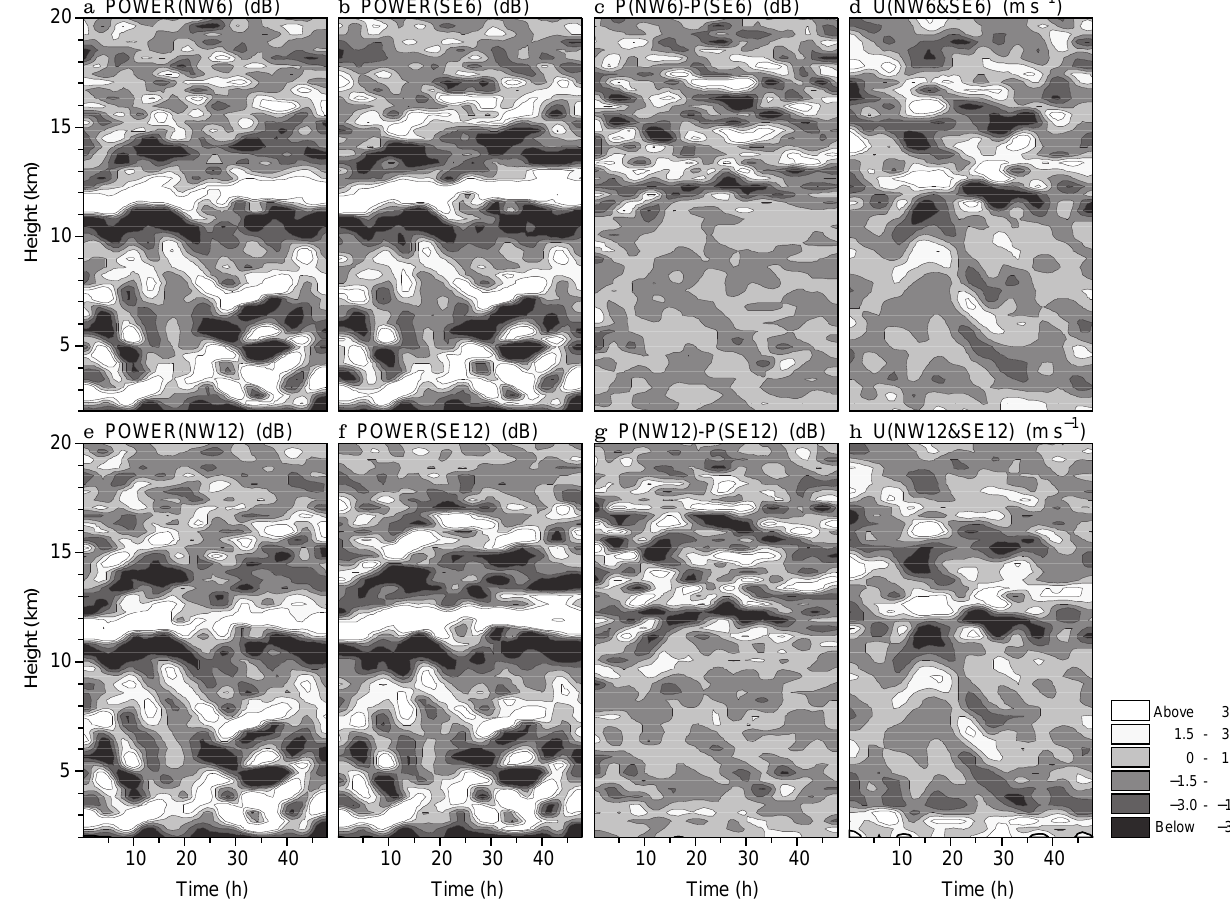
Fig. 1a–h. Perturbations of the radar echo power in the a NW6 (cid:14) ; b SE6 (cid:14) ; e NW12 (cid:14) ; f SE12 (cid:14) beams; di(cid:128)erences of echo power between c NW6 (cid:14) and SE6 (cid:14) ; g NW12 (cid:14) and SE12 (cid:14) beams; horizontal wind velocity perturbations in the NW–SE direction, measured by d NW6 (cid:14) and SE6 (cid:14) ; h NW12 (cid:14) and SE12 (cid:14) beam pairs. A wind velocity toward